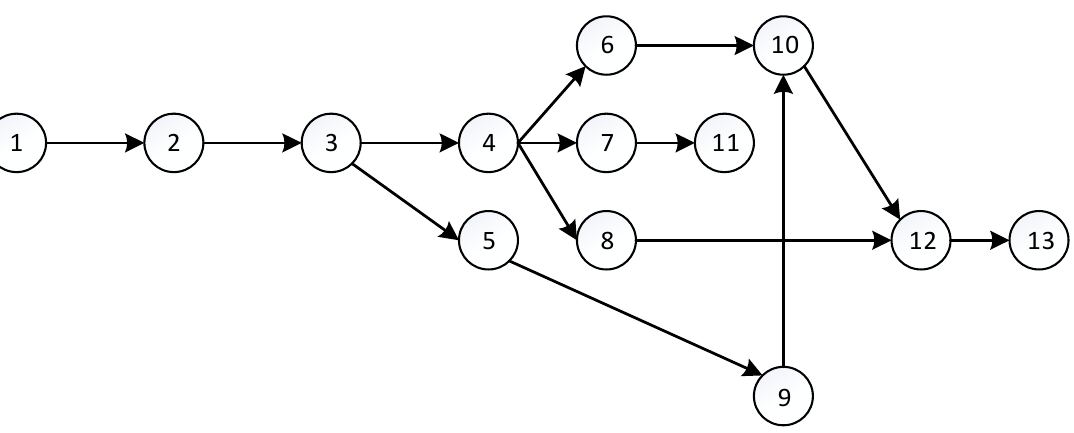
Figure 3. Project Network.